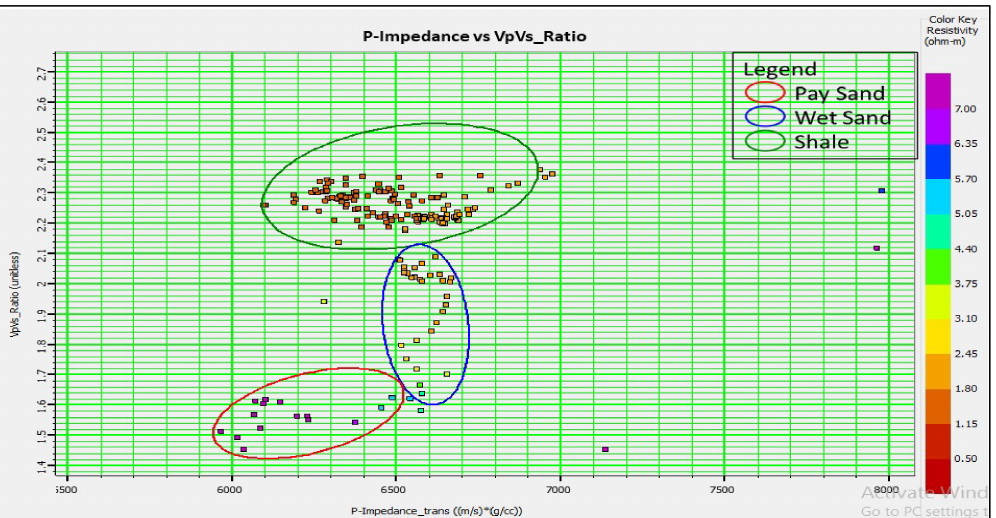
Figure 9. Vp/Vs ratio vs. P-impedance cross plot with colour-coding based on resistivity for pay sand delineation. The cross-plot of µρ versus λρ presented in this study successfully distinguished the pay sand and shale in between Top H and H 60 horizons. From Figure 10, the pay sand is well characterised, occupying the low λρ and high µρ values in the red outline. This zone wet sand is outlined in blue which most of the data within this zone fall within a medium range of λρ and µρ values. The distinguished wet sand also showed a good correlation to